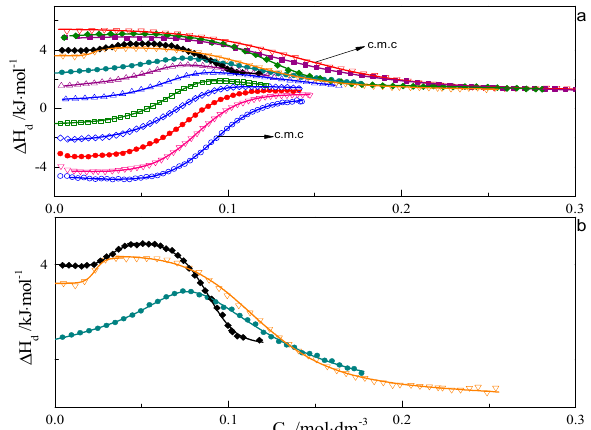
Figure 1. ( a ) Calorimetric titration curve from additions 8-8-8 surfactant to water for temperatures: ○ —283.15 K, ∇ —288.15 K, • —293.15 K, —298.15 K, □ —303.15 K, ∆ —308.15 K, ∆ —313.15 K, • —318.15